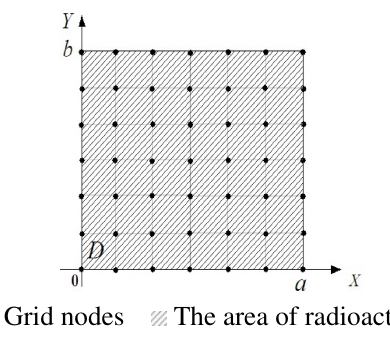
Fig. 1 Division of the search area